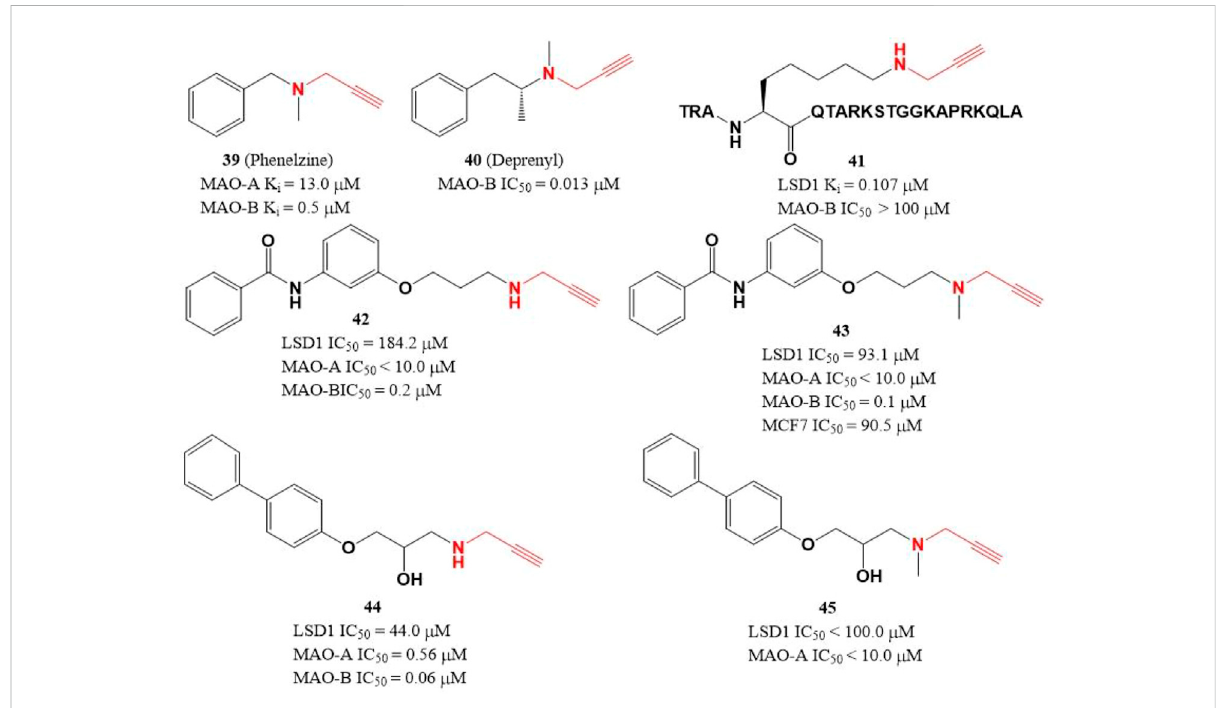
FIGURE 7 Structure of propargylamine-based LSD1 inhibitors.